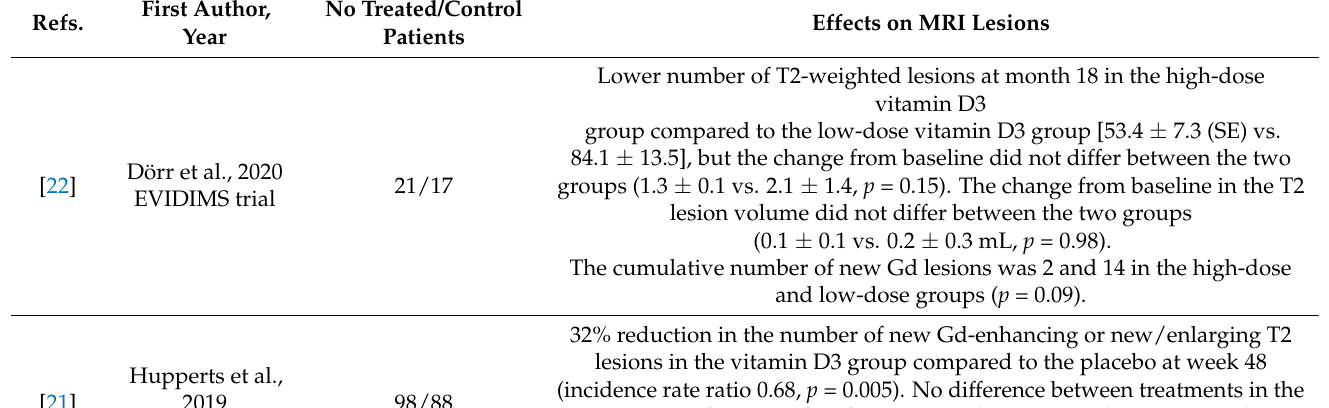
Table 7. Summary of observations on the MRI lesions in MS patients after vitamin D supplementation.